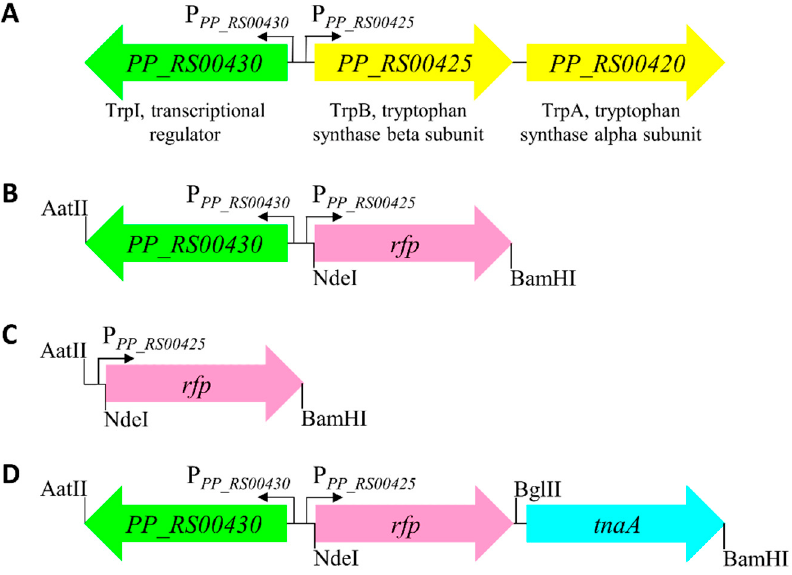
Figure 1. Schematic representation of the gene arrangement of the trpIAB operon and its derivatives used in this study. ( A ) The trpIAB operon, encoding transcription factor TrpI (locus tag PP_RS00430 ), and tryptophan synthase subunits alpha (TrpA, PP_RS00420 ) and beta (TrpB, PP_RS00425 ) in P. putida KT2440. The gene arrangement of ( B ) indole-inducible gene expression system Pp TrpI/P PP_RS00425 with rfp reporter gene assembled in the construct pPM0081 that was used for developing the whole-cell biosensor, ( C ) intergenic region ‘only’ containing promoter P PP_RS00425 followed by rfp gene (pPM0082), and ( D ) inducible system Pp TrpI/P PP_RS00425 with rfp reporter gene followed by tnaA gene encoding tryptophanase (pPM0083). AatII, NdeI, BglII, and BamHI represent positions of restriction sites, which were used for cloning and restriction analysis.